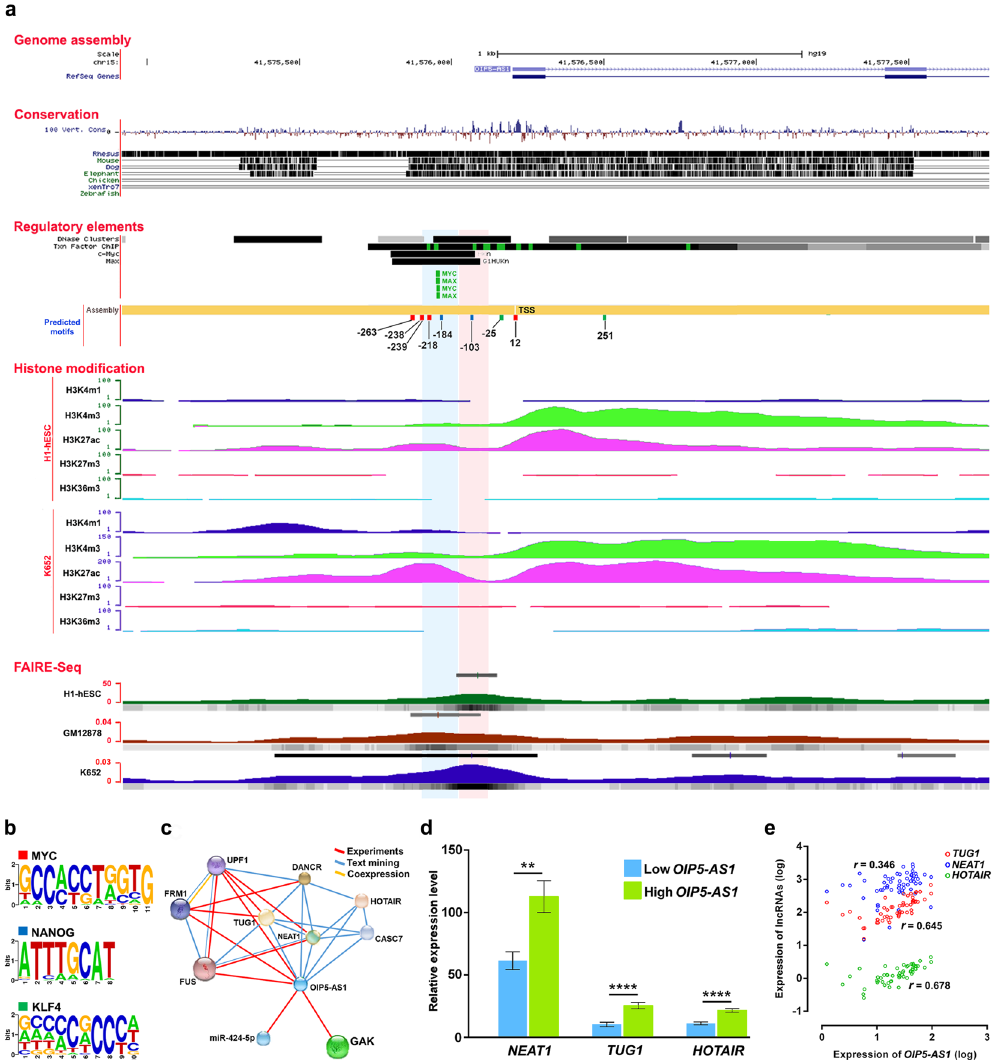
Figure 4. Epigenomic analysis of OIP5-AS1 promoter and expression of associated lncRNAs. ( a ) Graphical view of OIP5-AS1 promoter region with regulatory elements binding, histone modification signatures in H1- hESC and immortalized undifferentiated chronic myelogenous leukemia cell line (K562) and position of MYC (red), NANOG (blue) and KLF4 (green) motifs present around 1 kb up and downstream from TSS. H3K4me3 and H3K27ac signature are strong in hESC and cancer cells suggesting its active role in maintaining stemness in stem cells and cancer cells. Further, FAIRE-Seq (Formaldehyde-Assisted Isolation of Regulatory Elements) displayed strong TF binding around the NANOG motif in hESC and MYC motif in cancer cells suggesting that the stemness regulatory pathways is facilitated by NANOG in hESC and MYC in cancer cells. ( b ) Sequences of MYC, NANOG and KLF4 motifs screened in the promoter sequence of OIP5-AS1 . ( c ) Interaction network of OIP5 -AS1 through bioinformatics screening showing OIP5-AS1 interacts with NEAT1, TUG1 and HOTAIR . ( d ) Expression levels of lncRNAs NEAT1, TUG1 and HOTAIR between OIP5-AS1 overexpressed and underexpressed oral tumors from this study. Statistical significance represented as ** for P < 0.01 and **** for P < 0.0001 (two-tailed Student’s t-test). ( e ) Correlation of expression between NEAT1, TUG1 and HOTAIR with OIP5-AS1 . TUG1 and HOTAIR have a significant correlation in expression with OIP5-AS1